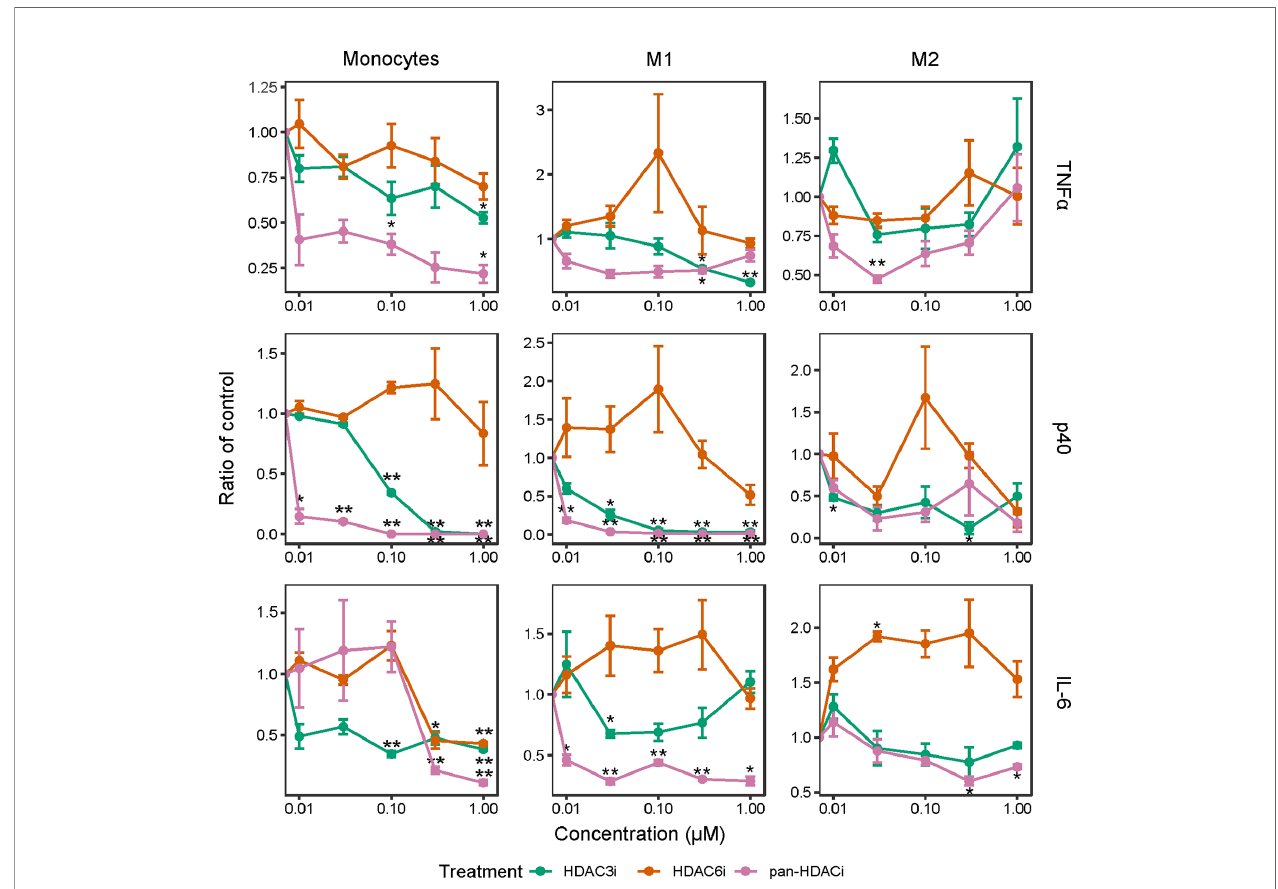
FIGURE 2 | Cytokine production over increasing HDACi dosage in LPS-stimulated macrophages. Freshly isolated primary human CD14 + monocytes and polarized M1 and M2 macrophages were treated with control DMSO or an increasing concentration of HDACi (12, 37, 111, 333 and 1000 nM) for 30 min. The cells were then stimulated with 100 ng/mL LPS for 24h. Protein levels of pro-in fl ammatory cytokines TNF a and IL-6, as well as p40 in the supernatant were measured by ELISA. The y-axis indicates the fold change in cytokine protein expression relative to DMSO control. From left to right: Monocytes, M1 macrophages and M2 macrophages. *P < 0.05; **P < 0.01